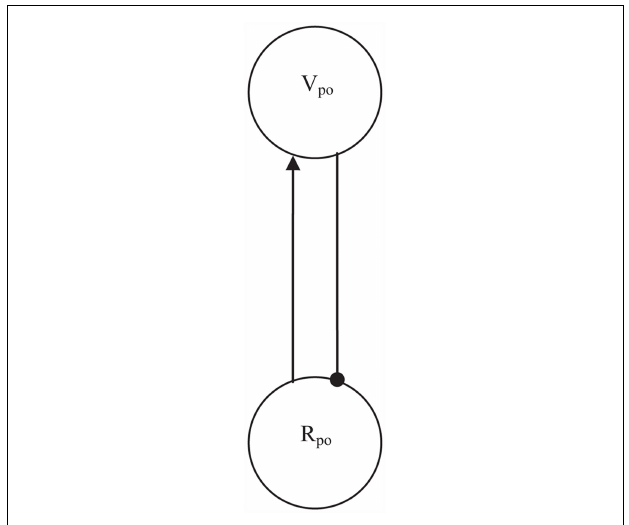
FIGURE 6 |Activation of R po results in oscillations through a flip–flop mechanism. Excitation ofV po by R po is followed by inhibition of R po fromV po in the next time step.With a constant input to R po this push–pull process repeats itself